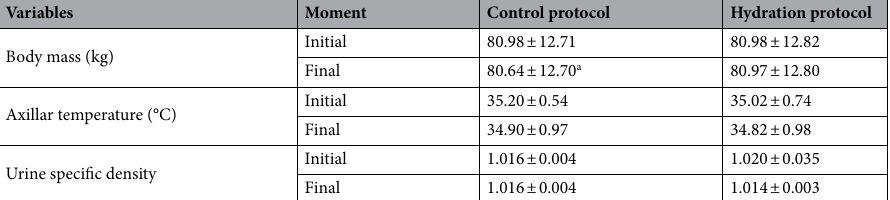
Table 2. Sample characterization in relation to body mass, axillar temperature, and urine specific density before and after protocols (N = 28). Mean ± standard deviation; kg kilogram, °C degree Celsius. a Difference between the initial body mass in the control protocol; p value = 0.000 (two-talied paired student t test).